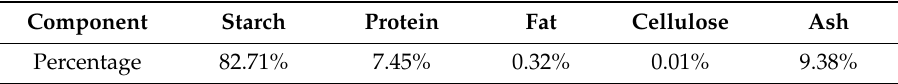
Table 1. The contents of each component in SF.